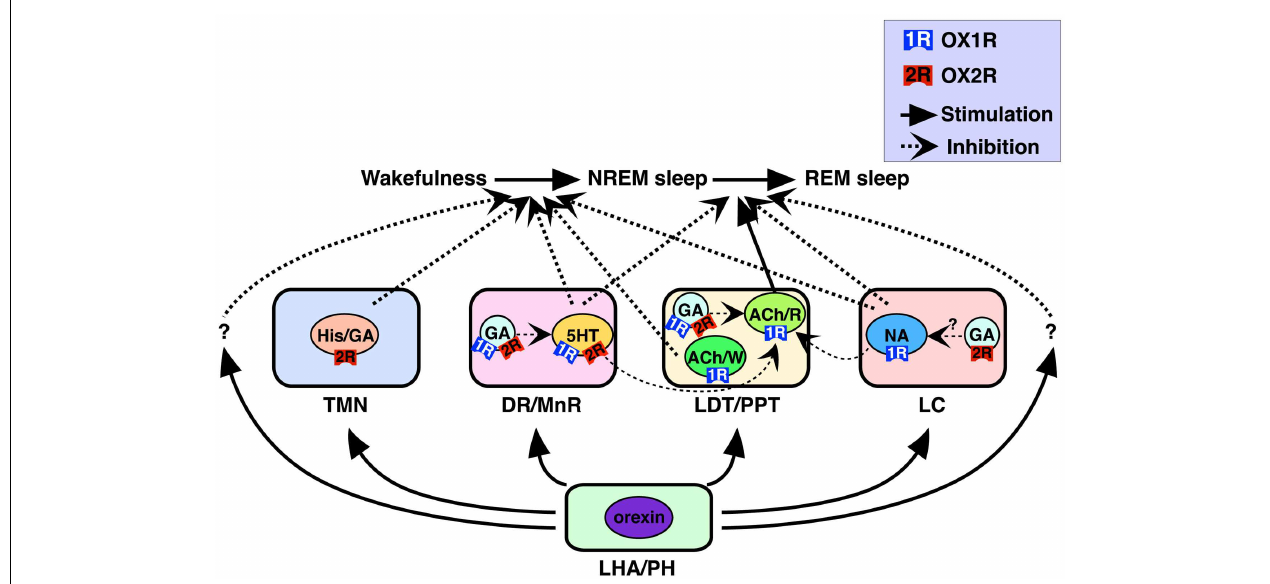
Wake/REM-on cholinergic neurons (ACh/W) are likely to suppress NREM sleep, but REM-on cholinergic neurons (ACh/R), are likely to induce REM sleep.Wake-active serotonergic and noradrenergic neurons in the DR/MnR and LC, respectively, counteract activation of REM-on cholinergic neurons in the LDT/PPT, as well as REM-on neurons in the brainstem reticular formation (Pace-Schott and Hobson, 2002; Sakurai, 2007). Previous reports have suggested contributions of GABAergic interneurons inhibiting PPT cholinergic and raphe serotonergic neurons (Liu et al., 2002;Takakusaki et al., 2005). LHA, lateral hypothalamic area; PH, posterior hypothalamus. Reproduced from Sakurai and Mieda (2011) with